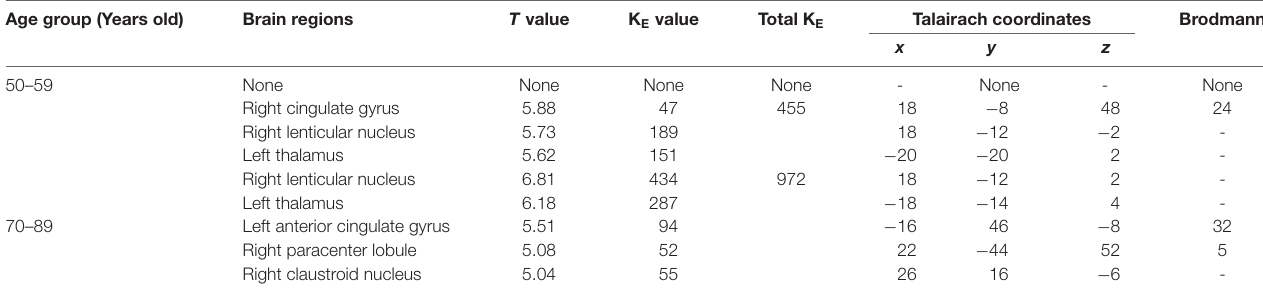
TABLE 5 | Brain regions with increased metabolism in males.